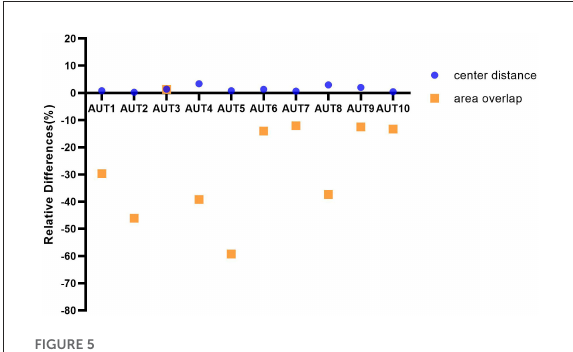
FIGURE5 The graph depicting ten AUTs’ relative differences of center distance and area overlap with respect to center hit, respectively.